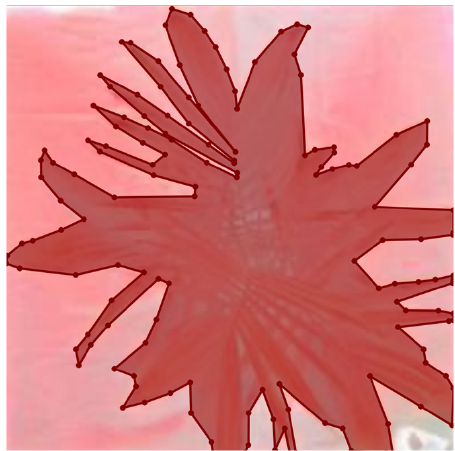
Figure 9. Example of the digitised labelled image of an oil palm seedling.